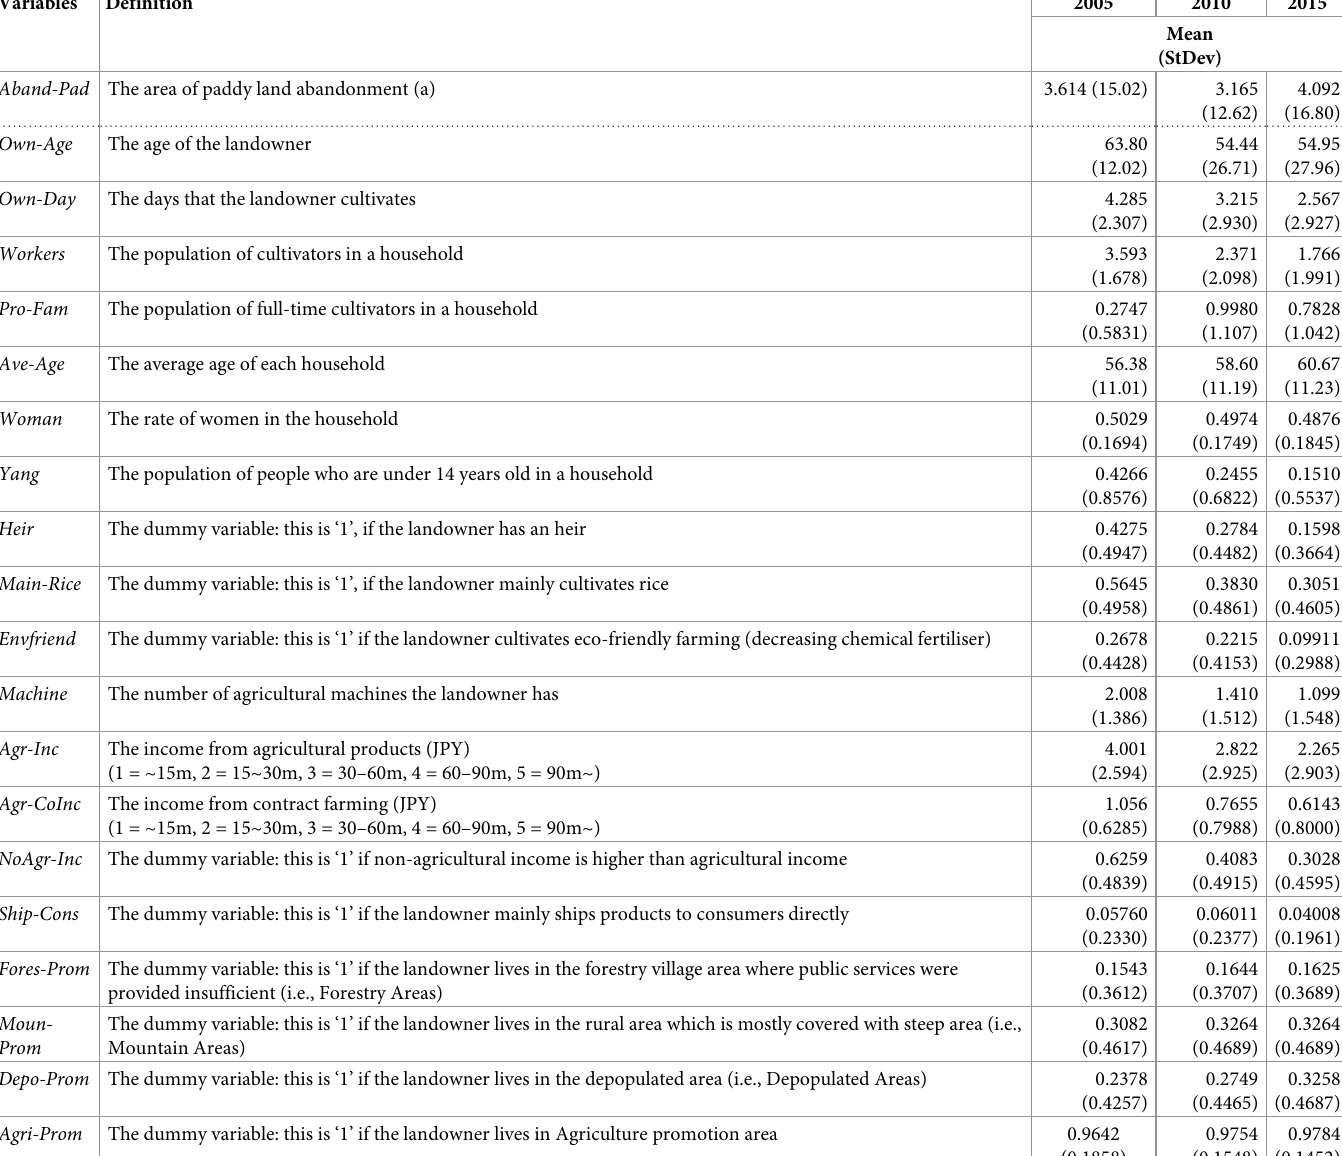
Table 1. The descriptions of the variables used in Tobit